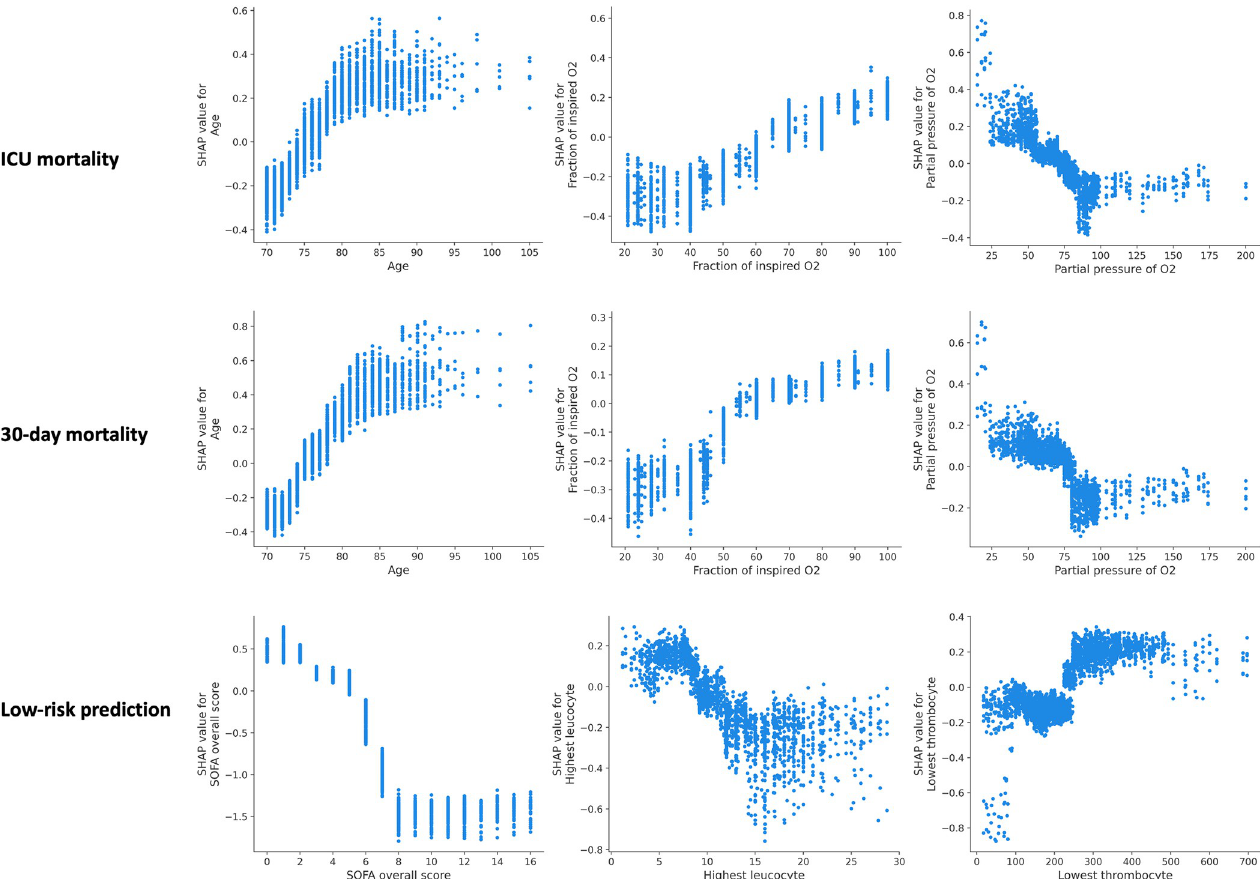
Fig 9. Dependency plots outlining relationship between the actual values of the variables (x-axis) and risk of predicted outcome (y-axis) expressed in terms of SHAP values. Higher SHAP values are associated with an increase in the risk of the outcome and vice-versa. For example, increasing age (x-axis in the top left graph), gradually increases the risk of predicted ICU mortality up to around 80 years. Beyond this value, the risk remains high. These results pertain to the model derived on the overall European cohort and validated externally on the non-European cohort. Values of FiO2 are expressed in percentages and PaO2 in mmHg, while leucocytes and thrombocytes are in million per microliter (x 10 9 / μ